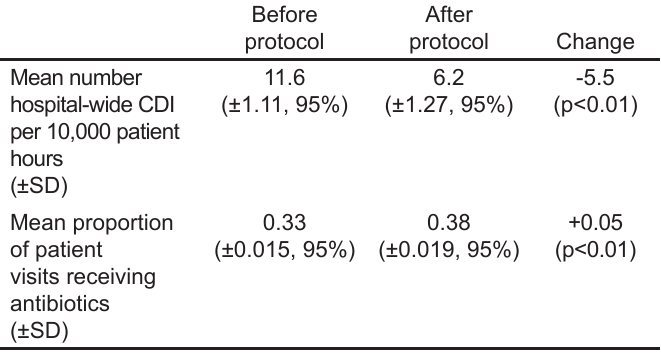
Table 2. Rate of Clostridium difficile infection (CDI) and proportion of patients receiving emergency department antibiotics before and after sepsis bundle